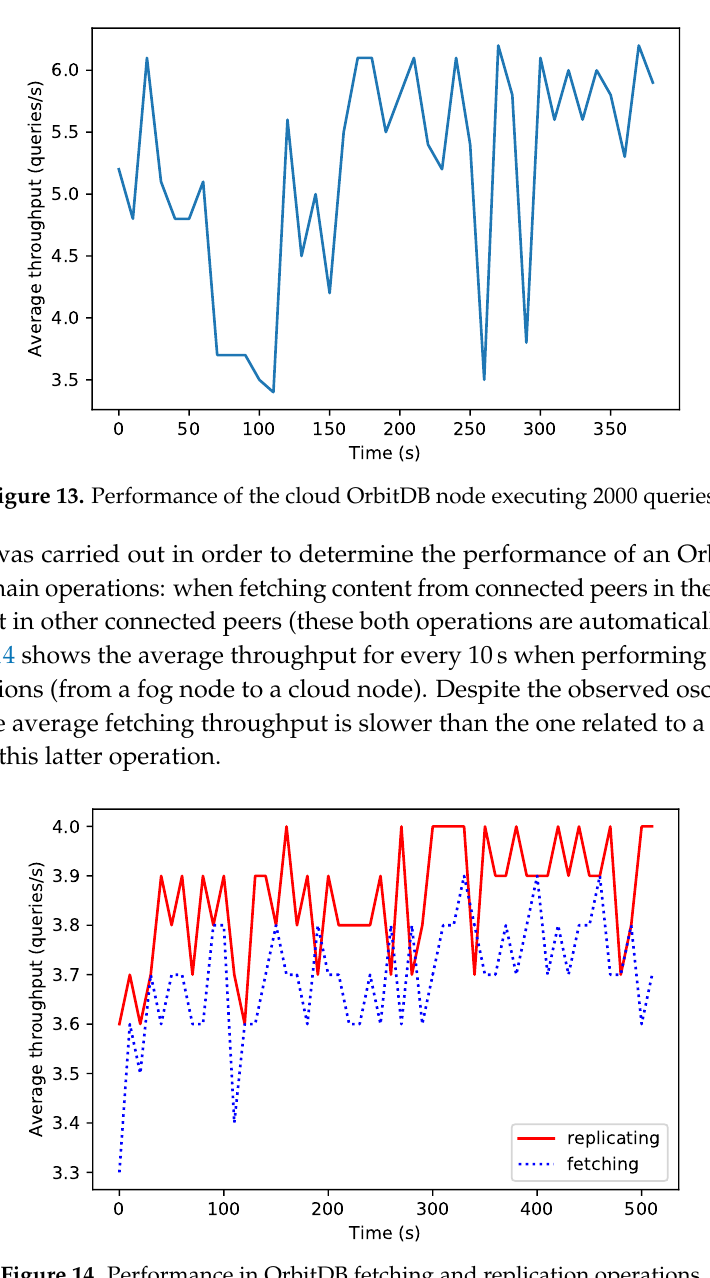
Figure 14. Performance in OrbitDB fetching and replication